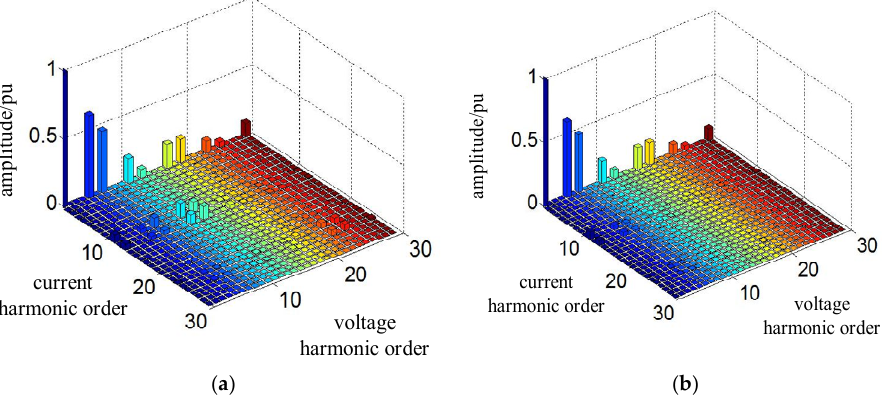
Figure 3. Positive sequence harmonic coupled admittance matrix elements of parallel 12-pulse rectifier. ( a ) Matrix Y + ; ( b ) Matrix Y + ∗ .